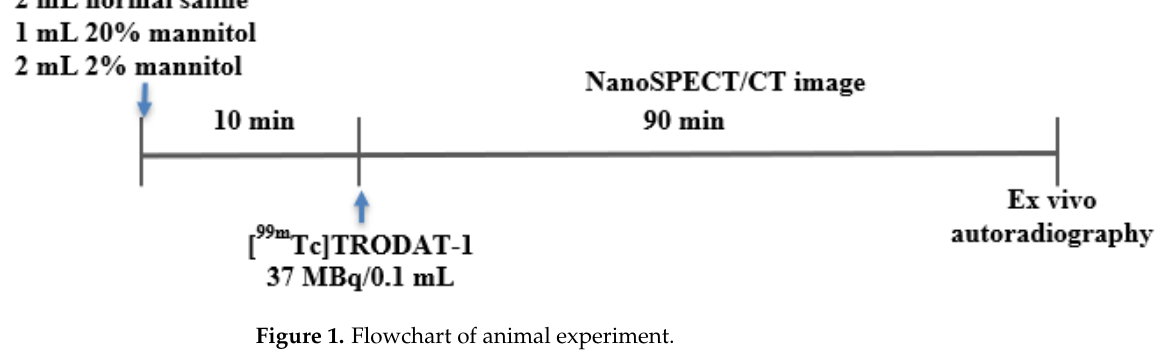
Figure 1. Flowchart of animal experiment.